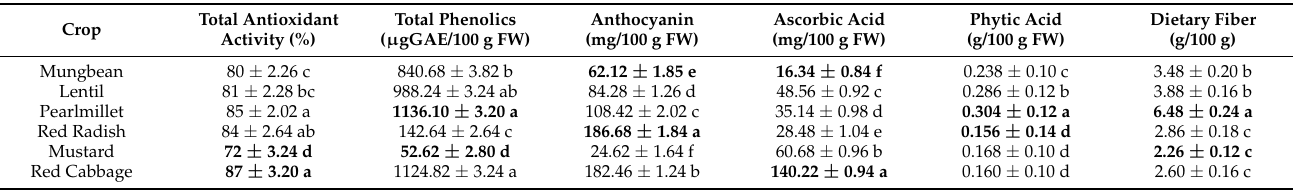
Table 7. Antioxidant activity and other bioactive components in